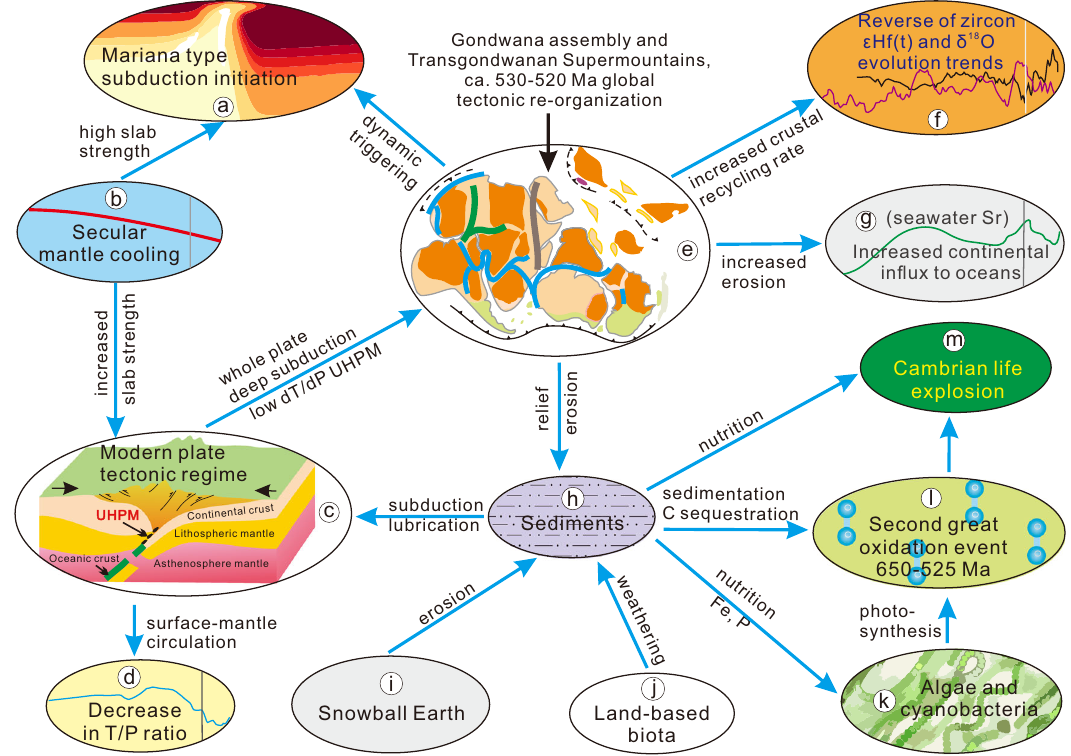
Fig. 7 Conceptual model for the establishment of modern tectonic regime and it ’ s links to tectonic events and surface environs. Links and driving menchanism between varied tectonic and surfacial proxies are presented. (7a, 7b, 7d, 7f, 7g are after or based on 5,21,26,28,75 and references therein,